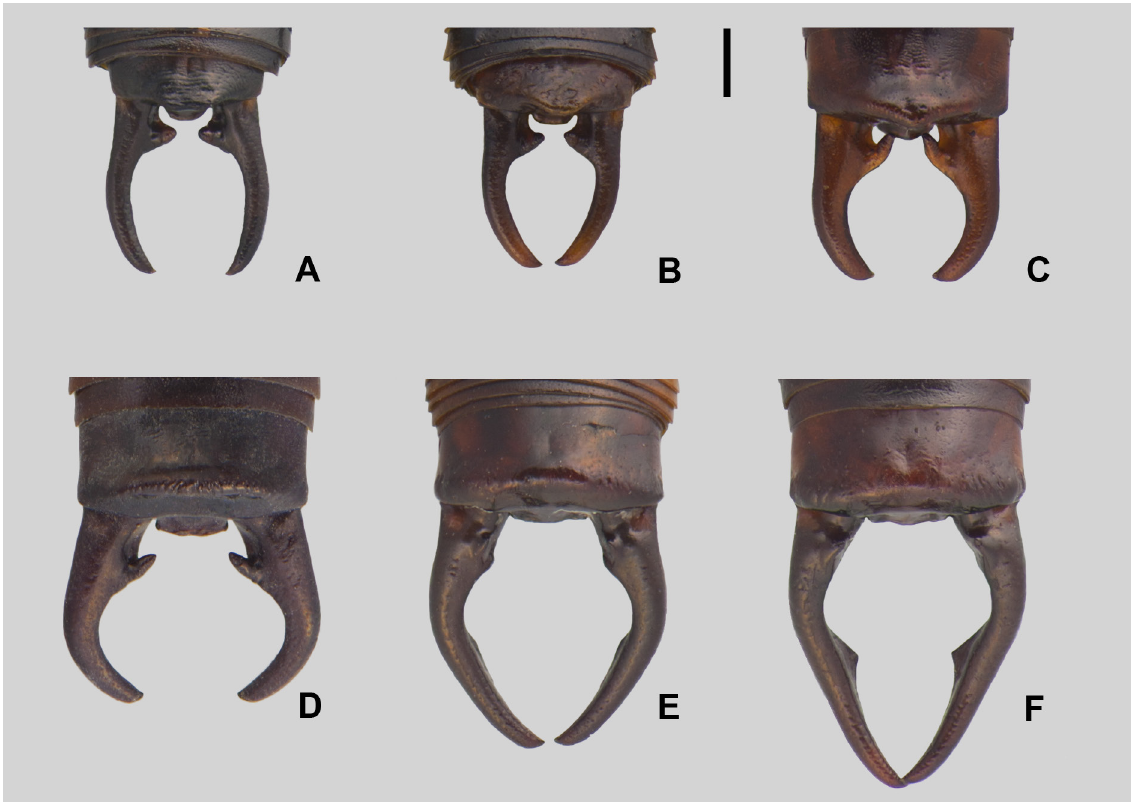
Fig. 3. Cerci variation in Pseudochelidura cantabrica Cuesta-Segura, Jurado-Angulo & García- París sp. nov., males. A . Puerto de Ventana (Asturias, Spain) (MNCN_Ent 167428). B . Puerto de La Farrapona (León, Spain) (MNCN_Ent 167426). C . Somiedo (Asturias, Spain) (MNCN_Ent